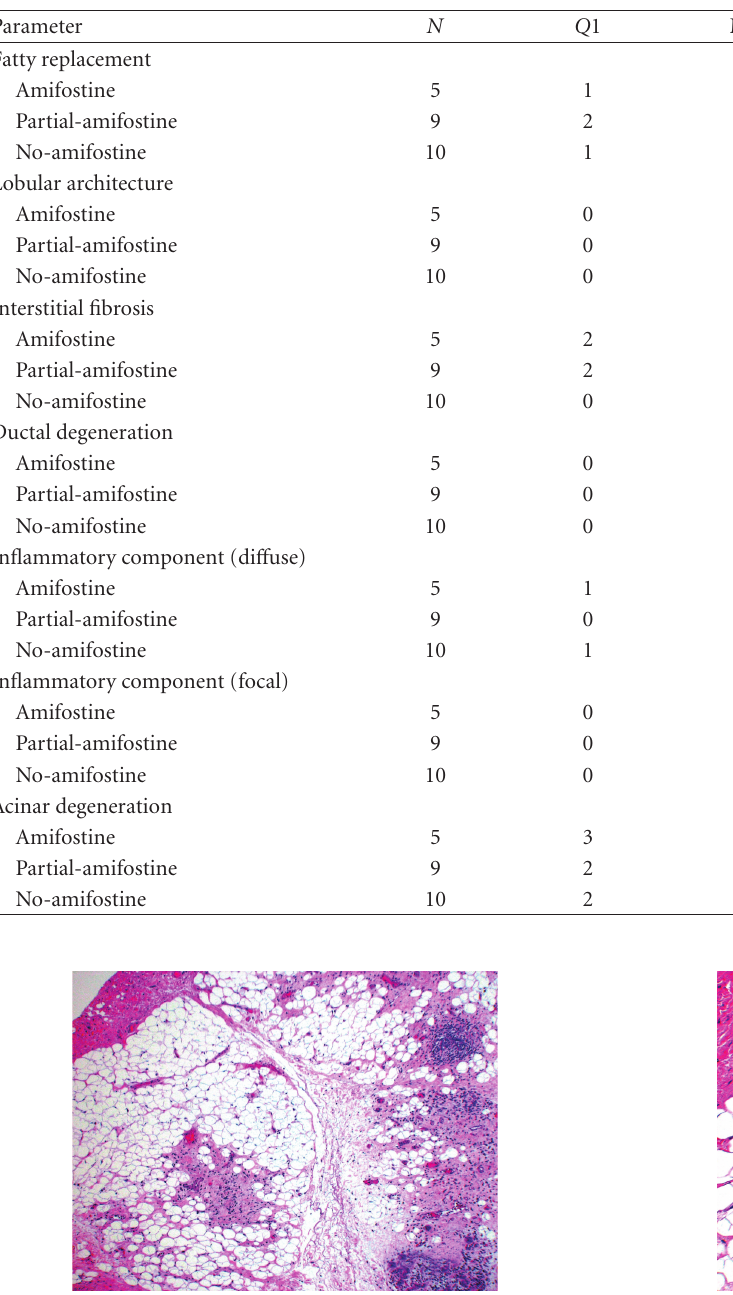
intensive chemoradiation therapy regimen did not show a clinically evident decrease in the incidence of xerostomia and mucositis with the use of amifostine [19]. Their findings question the possible added benefit of amifostine in patients undergoing